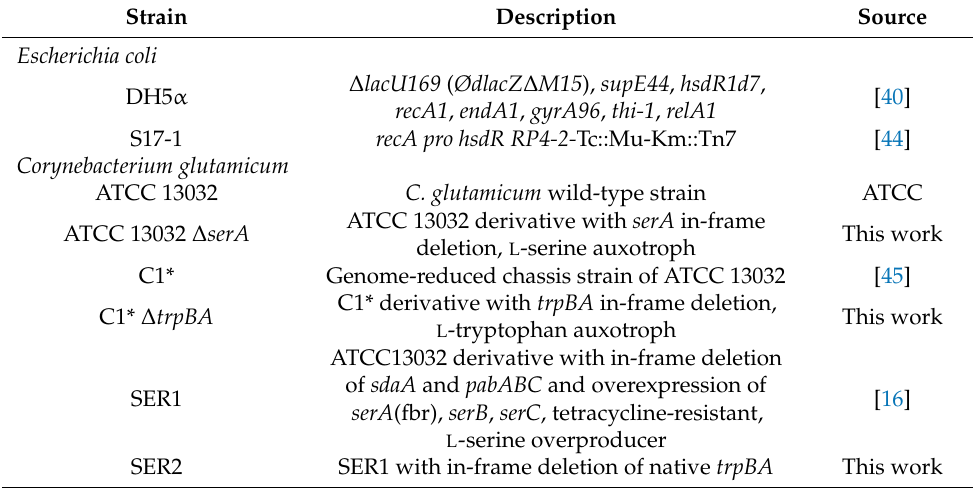
Table 1. Bacterial strains used in this study.